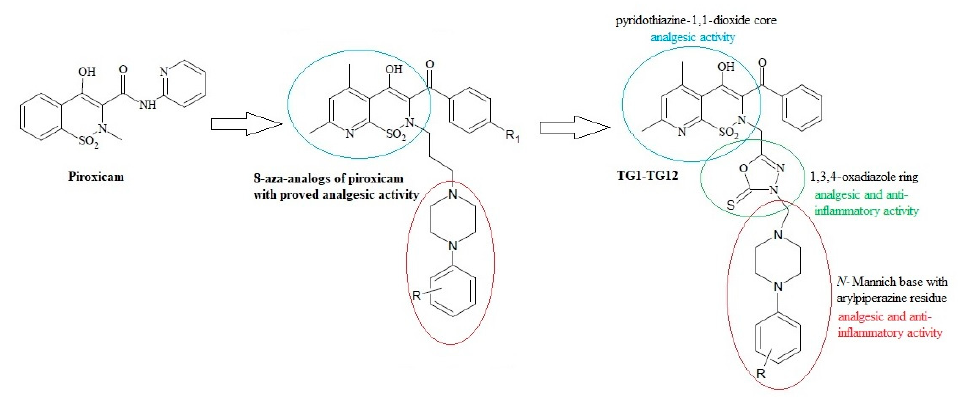
Figure 1. Scheme of the hybridization concept with the activity of individual structures.